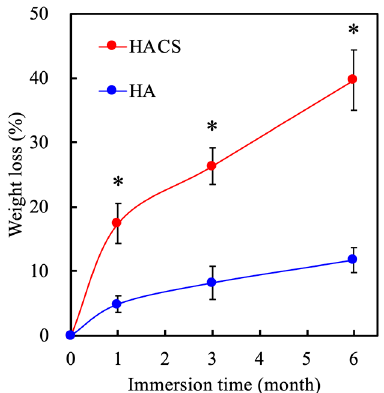
Figure 2. The degradation profile of HA and HACS scaffolds after being immersed in SBF for 6 months. Data are presented as mean ± SEM, n = 6 for each group. * p < 0.05 compared with HA.